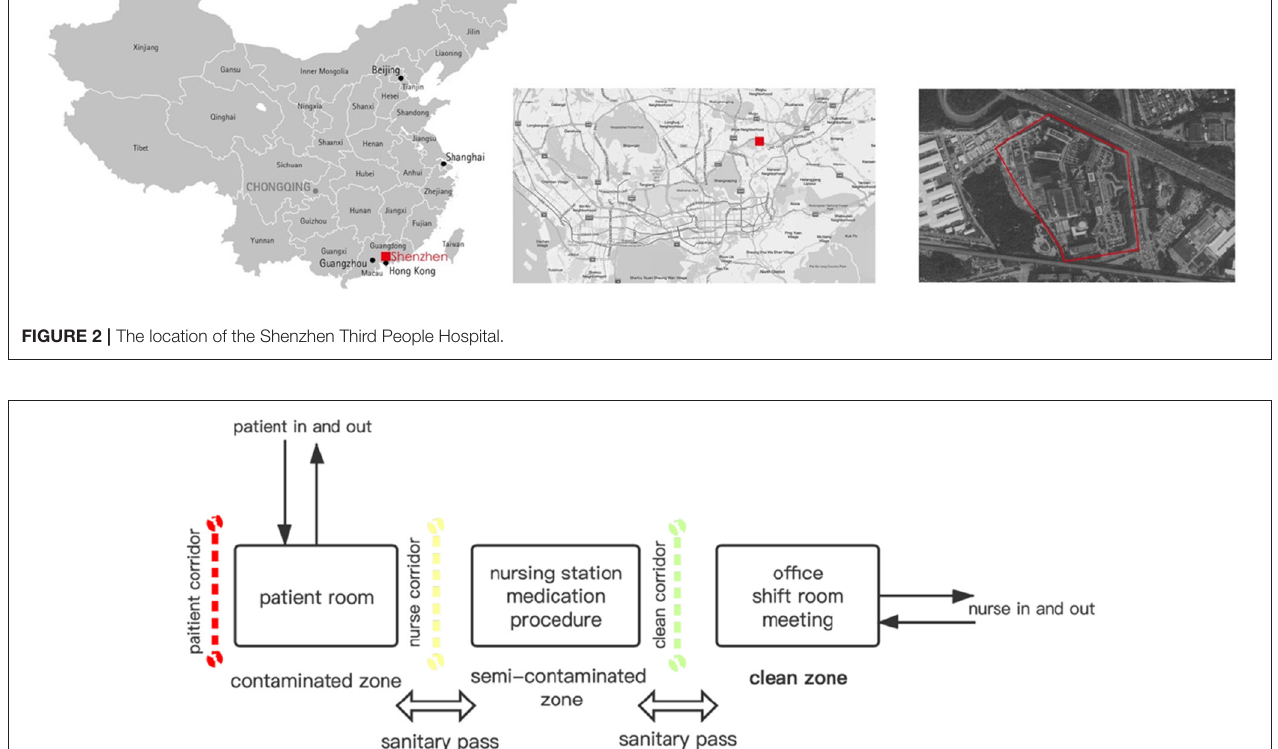
FIGURE 3 | The “Three Zone and Three Corridors” mode of infection disease nursing infection disease nursing unit.